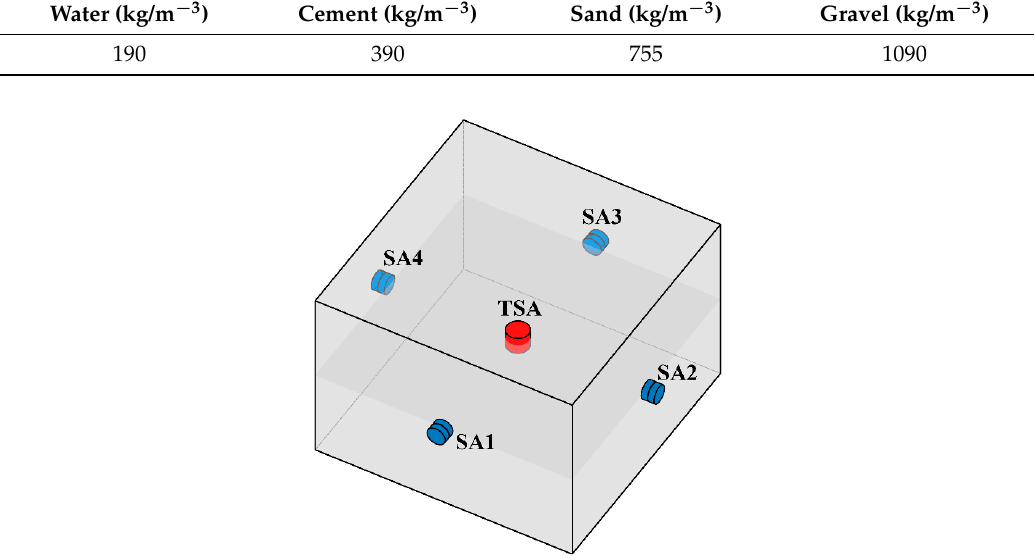
Table 1. The detailed parameters of the concrete.